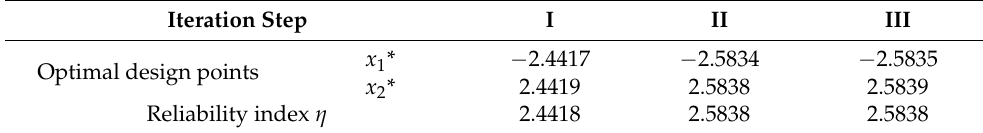
Table 1. Iterative process for solving Example 1.